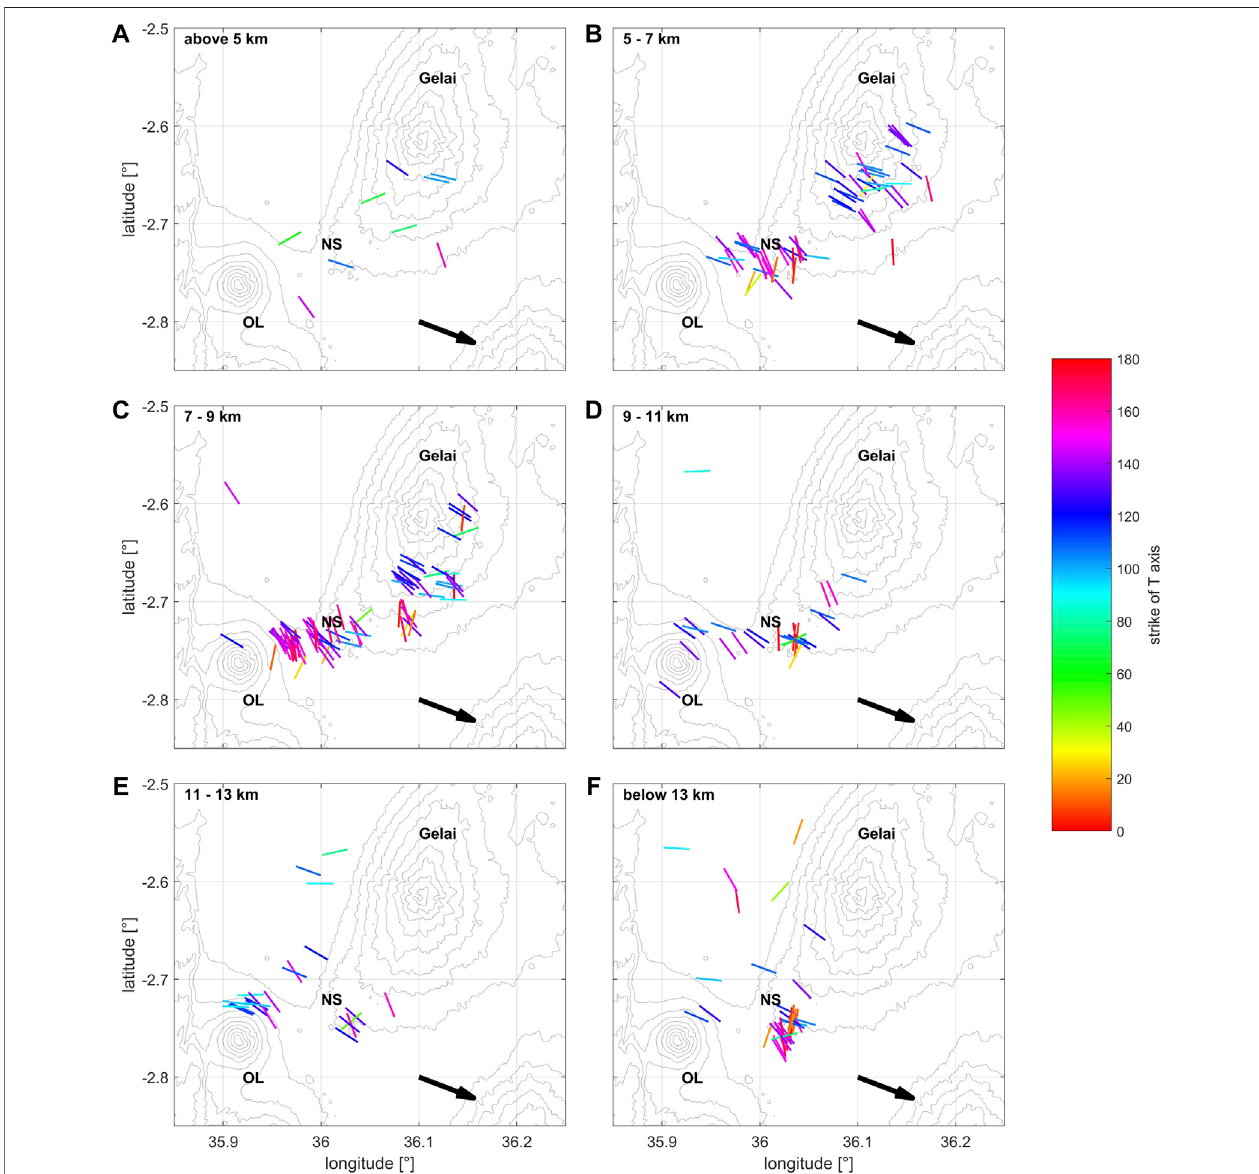
FIGURE 8 | Map view of T-axis direction of focal mechanisms. Axes are centered on earthquake location and colored by their azimuth. (A) 0 – 5 km depth. (B) 5 – 7 km depth. (C) 7 – 9 km depth. (D) 9 – 11 km depth. (E) 11 – 13 km depth. (F) below 13 km depth.